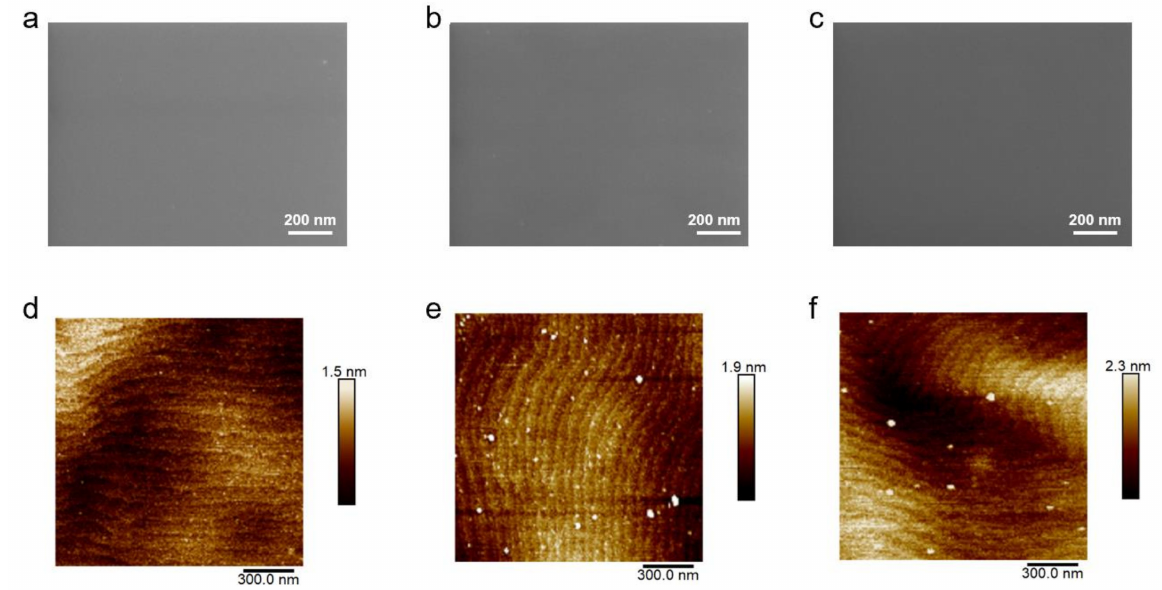
Figure 4. SEM images of LEDs ( a ) A, ( b ) B and ( c ) C. AFM images of LEDs ( d ) A, ( e ) B and ( f )